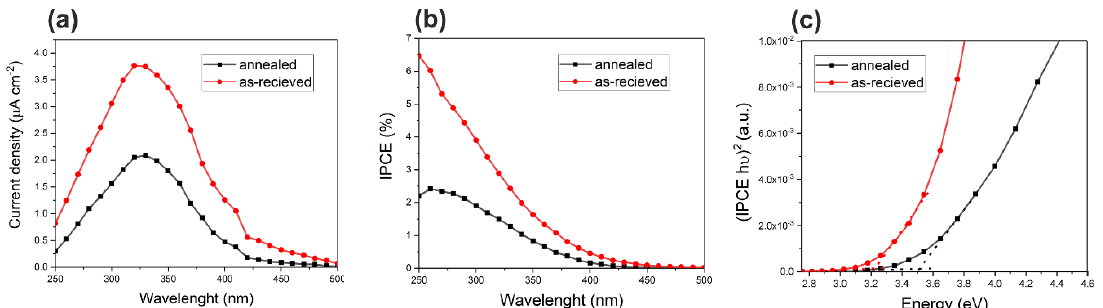
Figure 5. Photocurrent ( a ) and incident photon to current efficiency (IPCE) ( b ) as a function of the incident wavelength together with (IPCE h ν ) 2 vs. (h ν ) plot ( c ) for anodic layers obtained on metal foams.